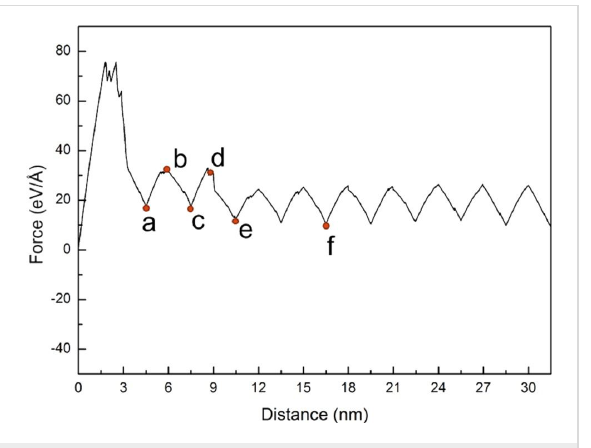
Figure 10: Force–distance curve of Fe under ten times of cyclic loading, where the first tension distance of the sample was 3 nm, and the compression and tension distances were 1.5 nm. The letters a–f represent the observation positions for the crack growth diagrams in Figure 11.